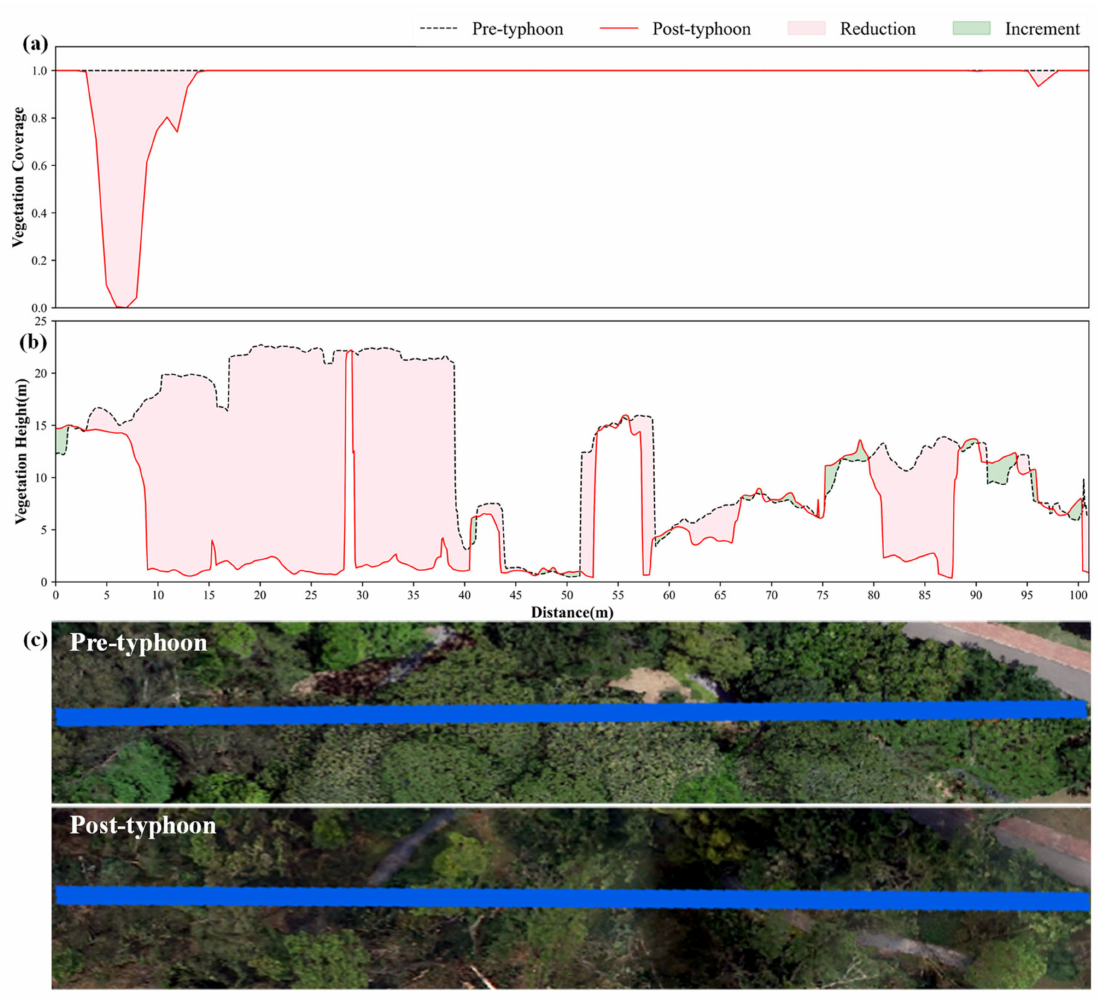
Figure 6. Changes in coverage and canopy height of the artificially landscaped forest on the sampling line before and after the typhoon. ( a ) The vegetation coverage; ( b ) the canopy height; and ( c ) the sampling